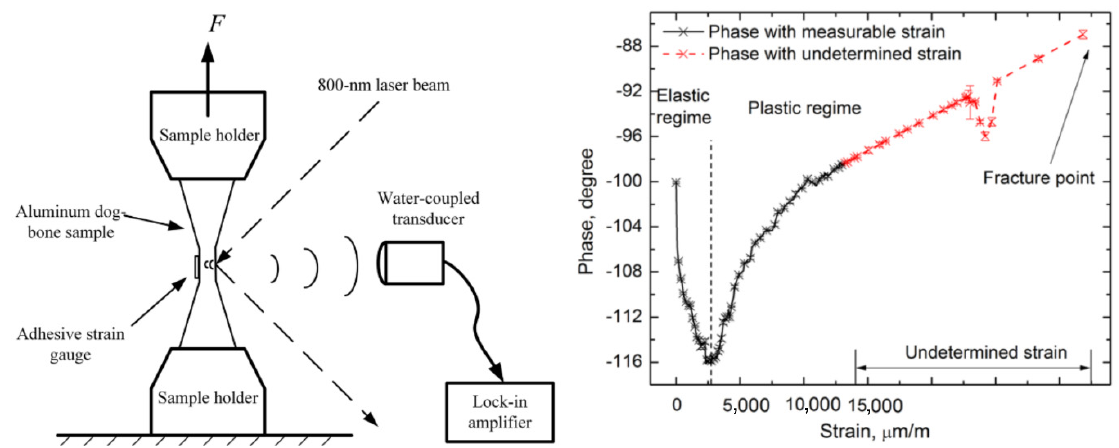
Figure 6. PA stress-strain test schematic with water coupling (left) and the stress-strain curve on the basis of PA phase (right); reproduced from [64] with permission from Springer Nature © 2017.